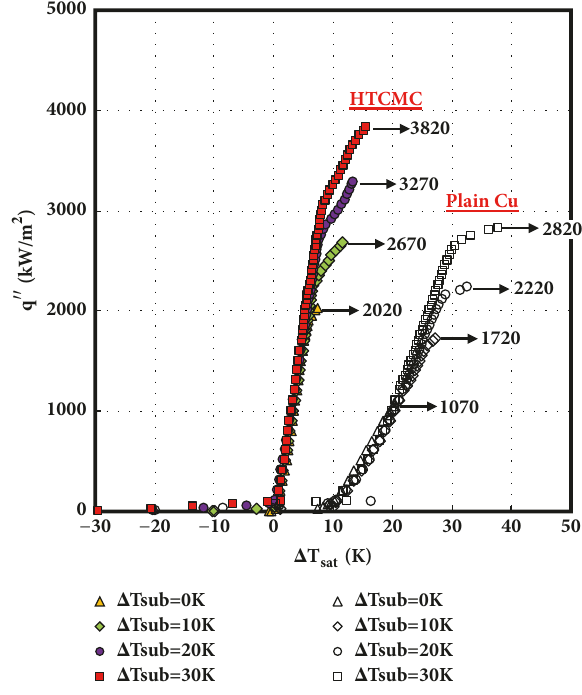
Figure 5: Boiling curves of HTCMC and a plain Cu surface at